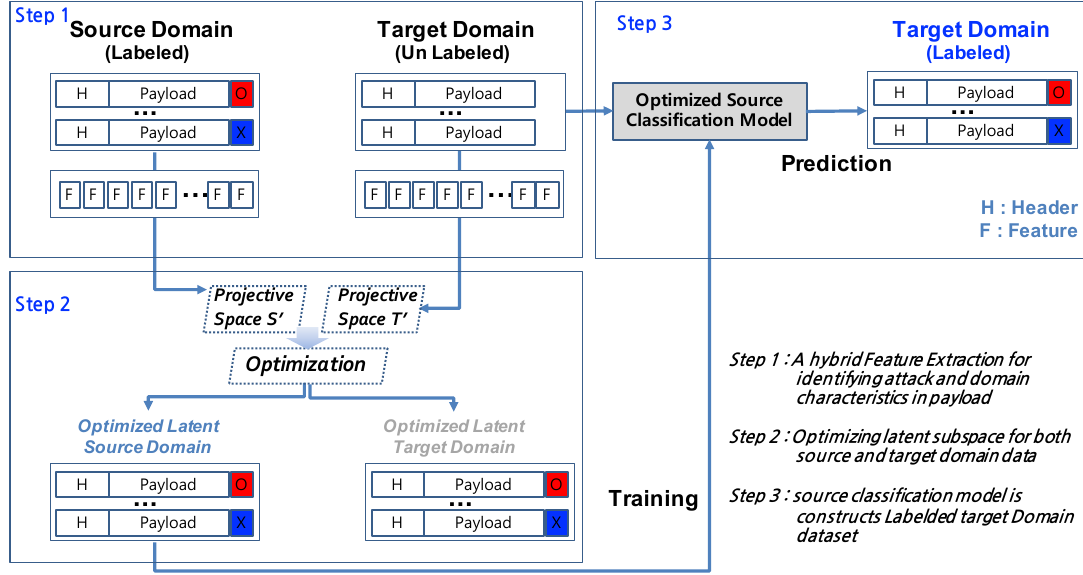
Figure 2. The proposed steps for PF-TL (payload feature-based transfer learning). The source domain contains labeled intrusion detection data that can be used as training data. The target domain contains unlabeled intrusion detection data that can be categorized as test data. The source and target domain data comprise attack and normal data and we assume that the source domain is labeled by an attack type and the target domain is